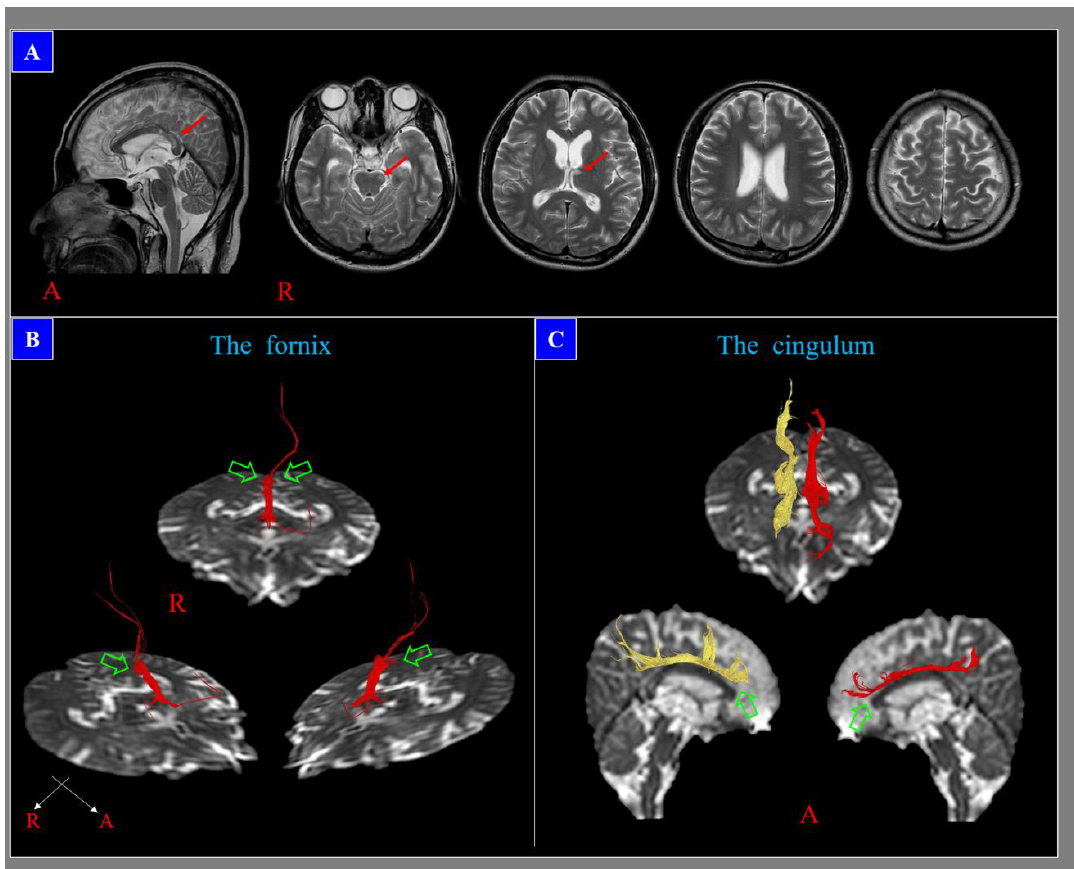
Figure 2. A 28-year-old male who showed loss of consciousness for ten days after a pedestrian–car accident, with diffuse axonal injury lesions (red arrows) in T2-weighted images ( A ). However, diffusion tensor tractography results reveal neural injuries (discontinuations (green arrows): both fornical crura ( B ) and anterior cingulums( C )) that are not related to these lesions; these neural injuries are consistent with the subject’s cognitive impairment, which developed after head trauma.